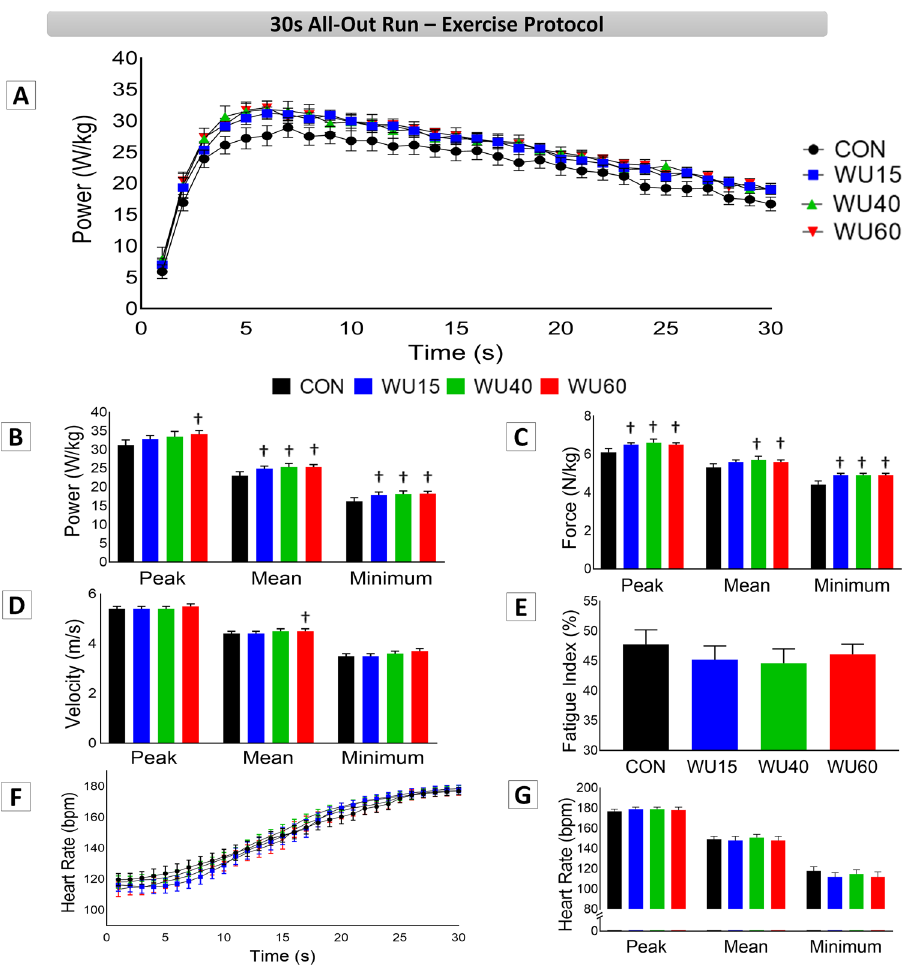
Figure 2. Mechanical and physiological results observed during the 30 s all-out run under control conditions (CON, black color) and after IMW loads at 15% (WU15, blue color), 40% (WU40, green color) and 60% of MIP (WU60, red color). ✝ Indicates difference in relation to the control session. (P <